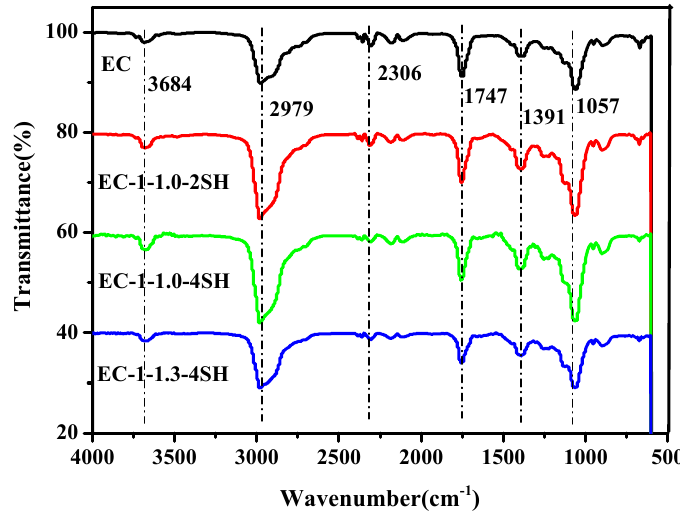
Figure 20. Two − dimensional FT − IR of EC, EC − 1 − 1.0 − 2SH, EC − 1 − 1.0 − 4SH and EC − 1 − 1.3 − 4SH.